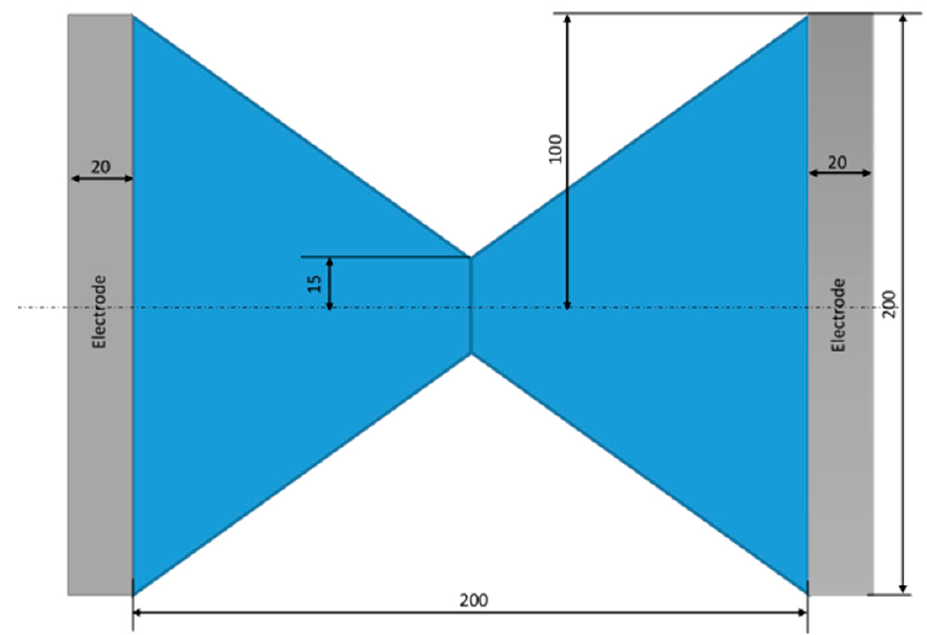
Figure 5. Geometry and dimensions (in mm) of the proposed experimental model.